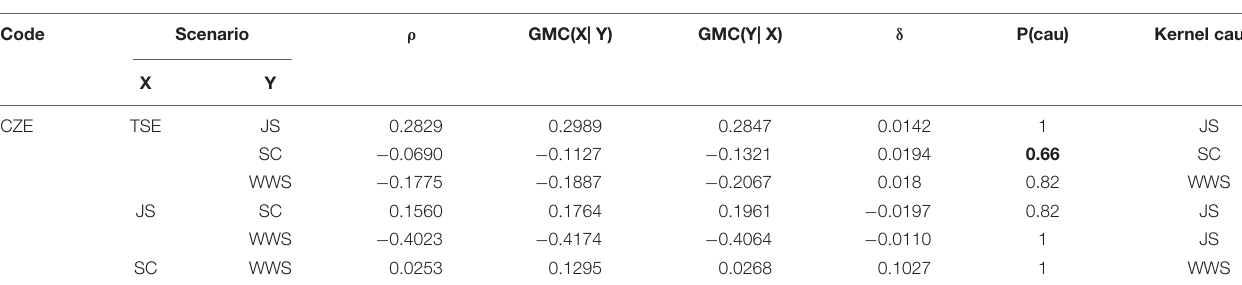
TABLE 6 | Summary of GMC for the Czechia.